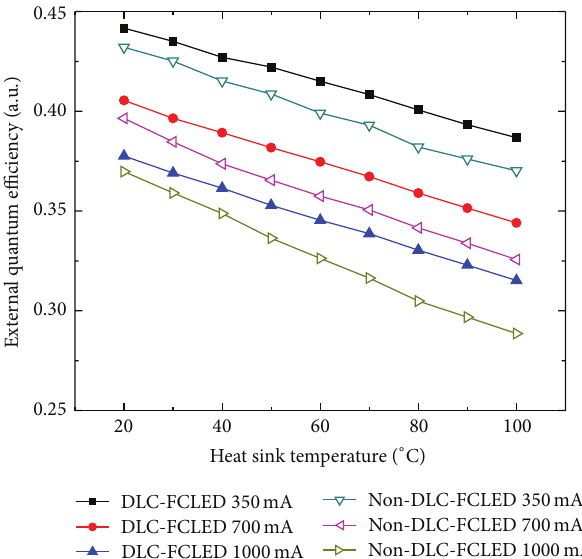
Figure 3: Three EQEs of the DLC-FCLED and non-DLC-FCLED as functions of the heat sink temperature at different injection currents (350, 700, and 1,000